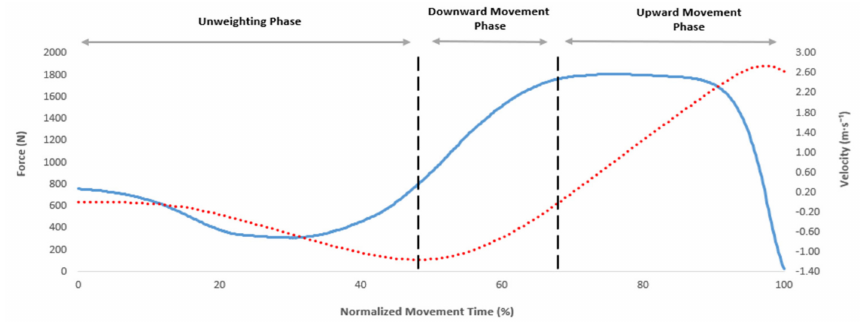
Figure 1. Countermovement jump phase interpretation based on force-time (blue solid line) and velocity-time (red dotted line) curve